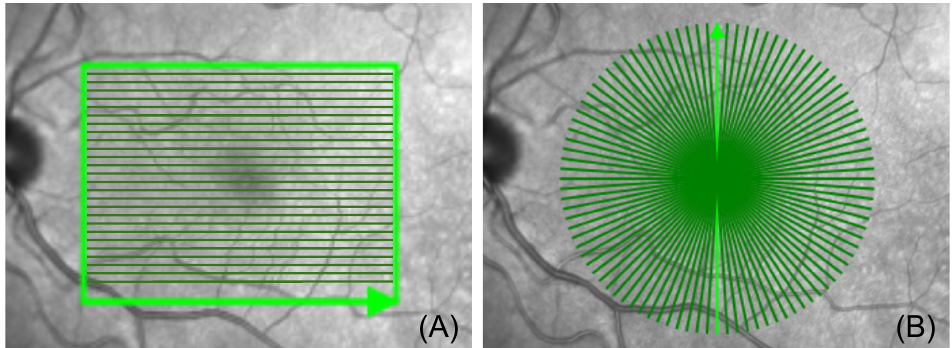
Figure 1. ( A ) shows the linear acquisition pattern, consisting of 145 linear slices around a center point with the first (1/145) acquisition slices highlighted in bright green. ( B ) shows the radial acquisition pattern consisting of 48 radians/slices around a center point, with the first (1/48) acquisition slice highlighted in bright green (Spectralis OCT, Heidelberg Engineering, Germany). Note the dense acquisition area around the acquisition center in image ( B